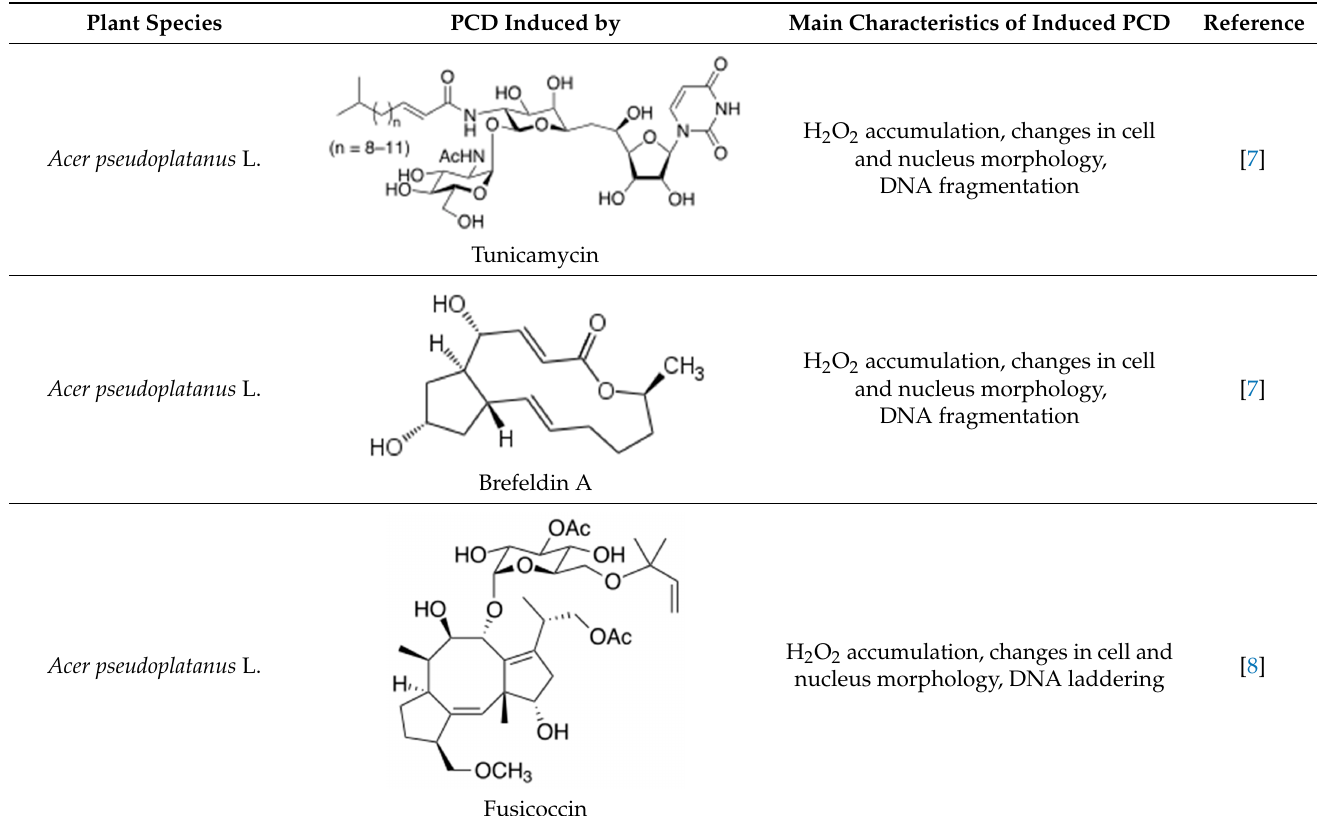
Metabolic products present in the Alternaria alternata culture filtrate Cytoplasm shrinkage, chromatin condensation, DNA laddering Culture filtrates of Erwinia carotovora Changes in vacuole shape, endoplasmic actin filaments